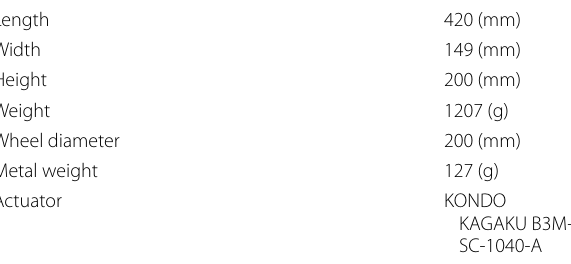
Table 1 Specifications of Semicircular wheel